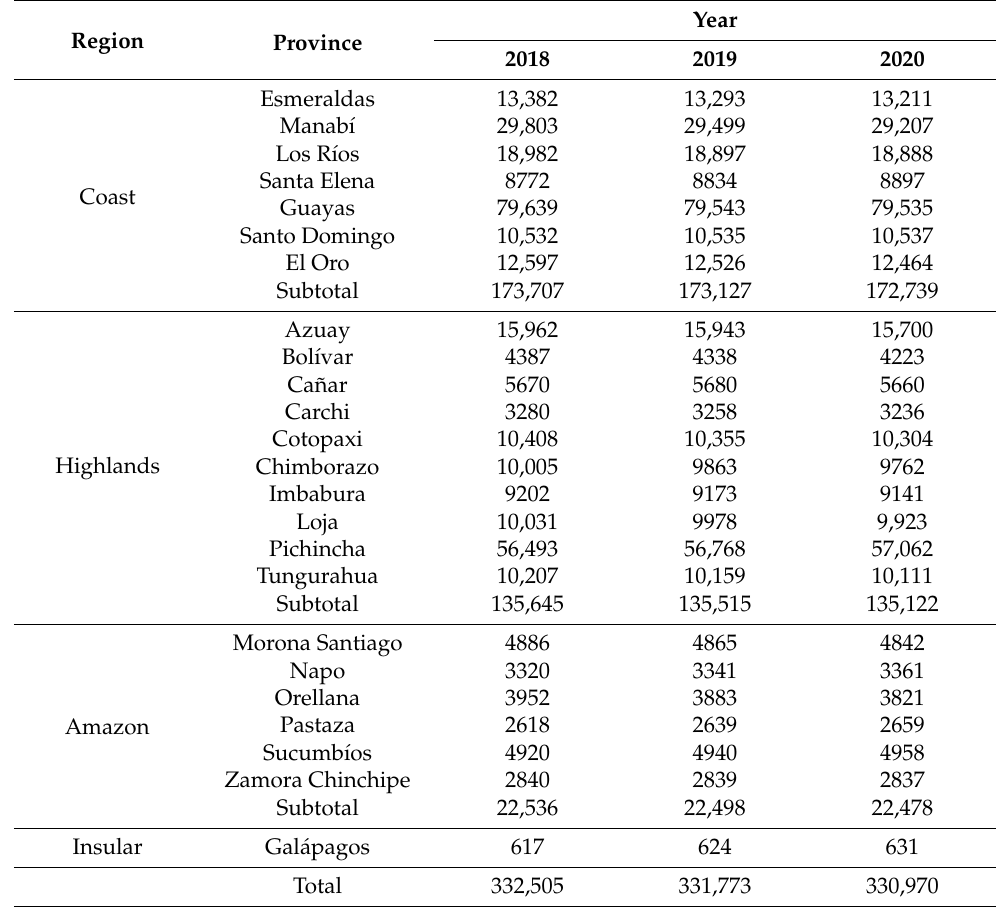
Table 1. Total population of infants from the 24 Ecuadorian provinces. Region